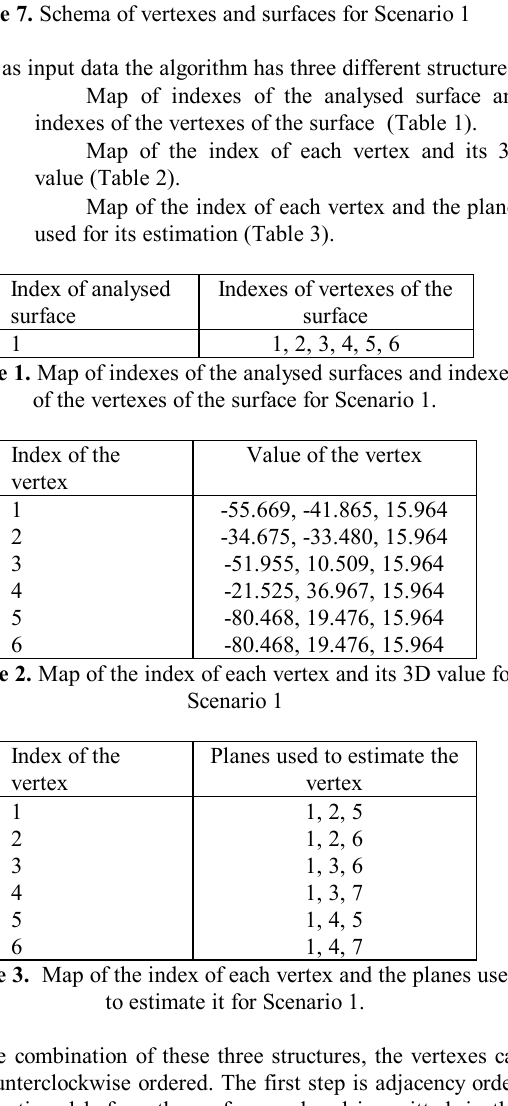
Figure 9. Schema of vertexes and surfaces for Scenario